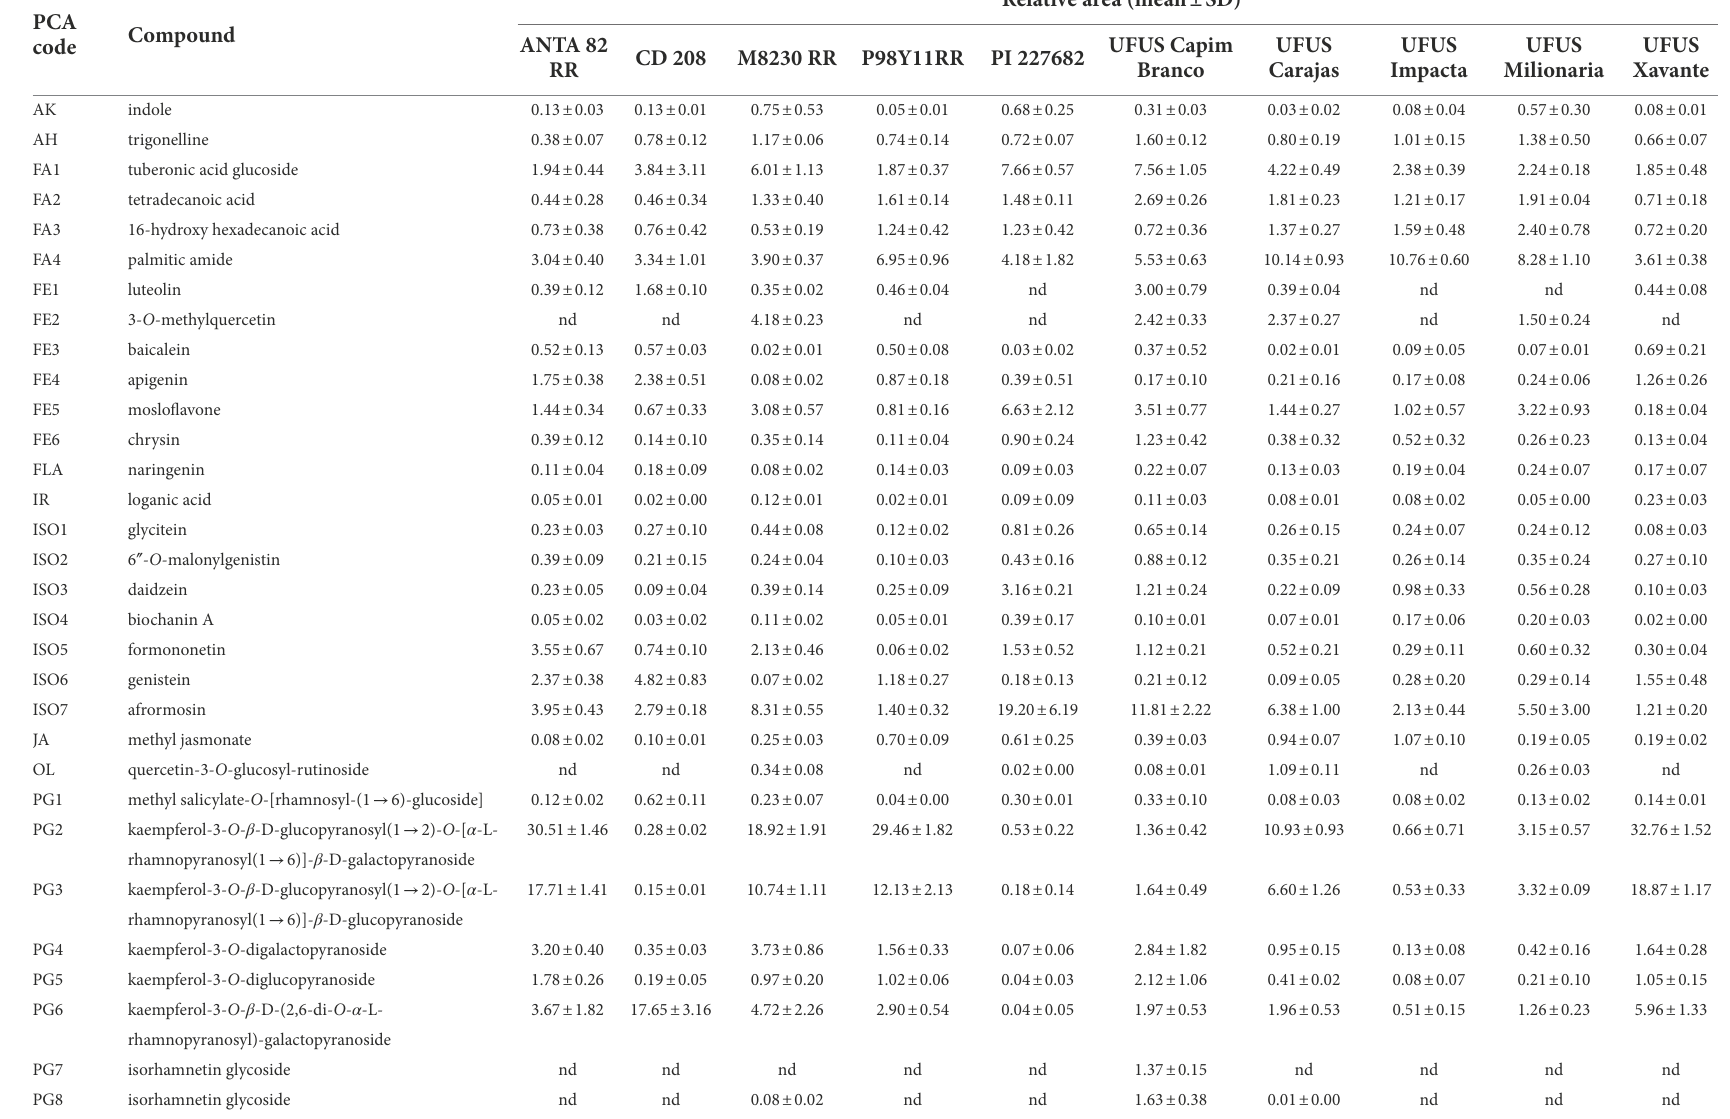
TABLE 2 Glycine max leaf nonvolatile compound relative areas extracted from 10 different cultivars.